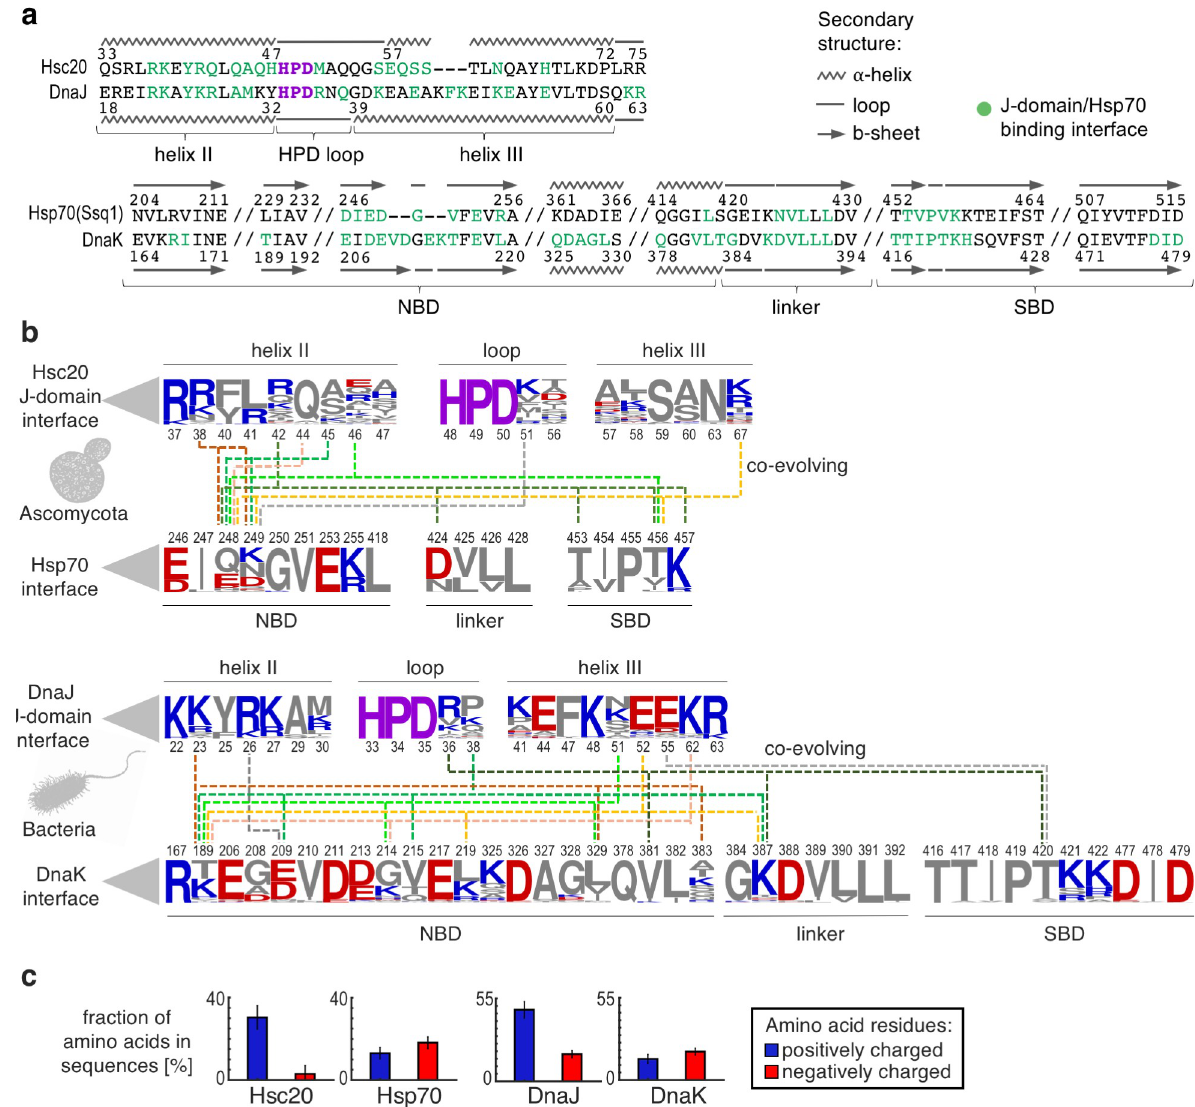
Fig 5. Sequence variability of J-domain/Hsp70 binding interface. (a) Pairwise sequence alignments of the J-domain/Hsp70 interfacial regions of the J-domains Hsc20 and DnaJ’s (top) and the Hsp70s Ssq1 and DnaK (bottom). Residues of each protein that are in contact across the Hsc20/Ssq1 and DnaJ JD /DnaK binding interfaces are in green; HPD motifs in purple. (b) Sequence variability of positions that form the J-domain/Hsp70 binding interfaces (those positions shown in green in panel a) for orthologs of Hsc20/Ssq1 from 67 Ascomycota species (top) and DnaJ/DnaK from 117 bacteria species (bottom). Coevolving positions with p > 0.01 statistical support (S2 Table, S3 Table, S16 Fig and S17 Fig) are connected by dashed lines. Sequence logos represent the amino acid frequency of each interfacial position in the orthologs examined, with positively charged (blue), negatively charged (red) and uncharged (grey) residues. Position numbering is that for S . cerevisiae (top) and E . coli (bottom) sequences. (c) Fraction of interfacial Hsc20/Ssq1 and DnaJ JD /DnaK residues that are positively and negatively charged. Whiskers indicate standard deviation.